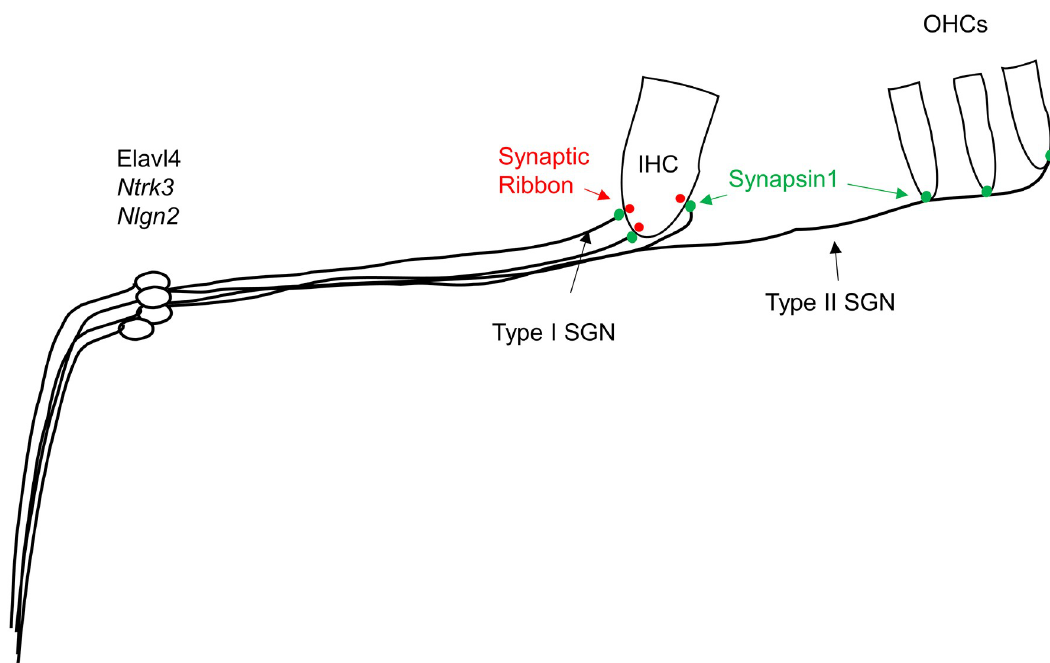
Fig 9. Schematic illustrating localization of genes of interest. ELAV-like protein 4, encoded by Elavl4 , as well as Ntrk3 and Nlgn2 localize to the spiral ganglion area. Synapsin 1 (green), encoded by Syn1 , was found to be present at the synapse between spiral ganglion neurons with inner and outer hair